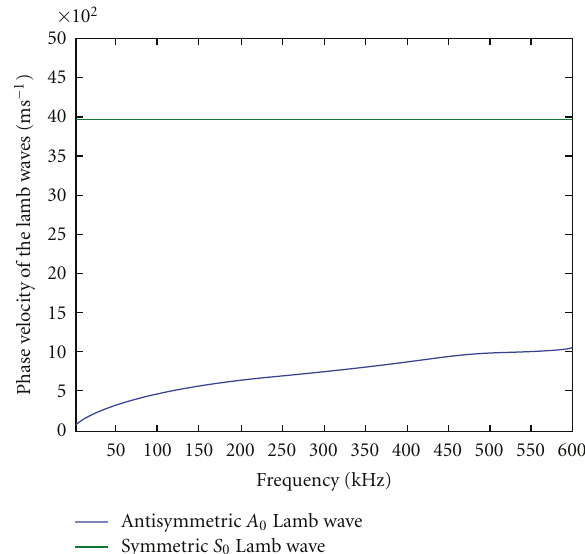
Figure 13: Lamb wave phase velocities calculated for the outermost copper layer in the type C cable. Symmetric and antisymmetric waves are shown.